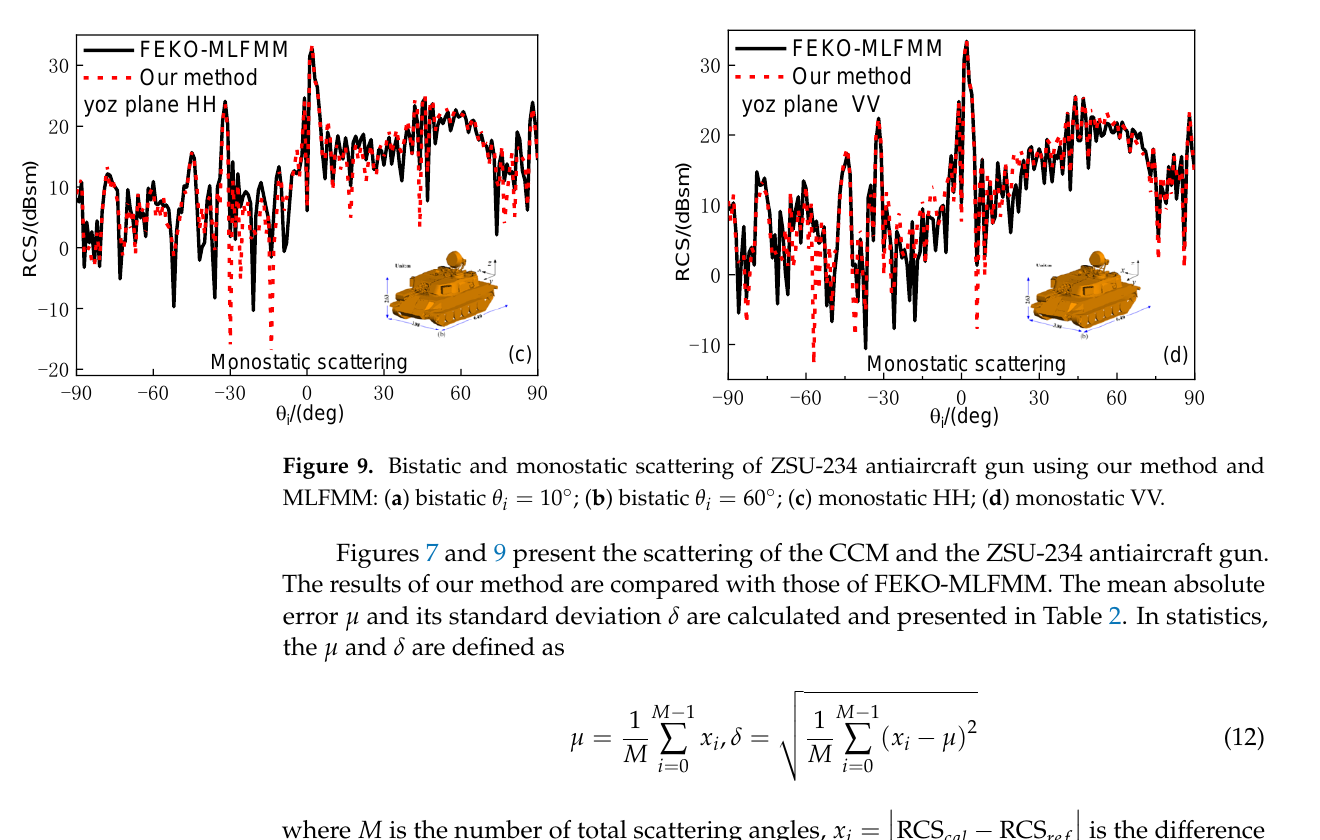
where M is the number of total scattering angles, x i = between the calculated radar cross-section (RCS) ( RC S between the calculated radar cross-section (RCS) (RCS cal ) by the proposed method and the reference values RCS ref by the FEKO-MLFMM. The µ and δ in Figures 7 and 9 are about 1.37~2.84 and 1.40~3.05, respectively. These illustrate that the results by the two methods